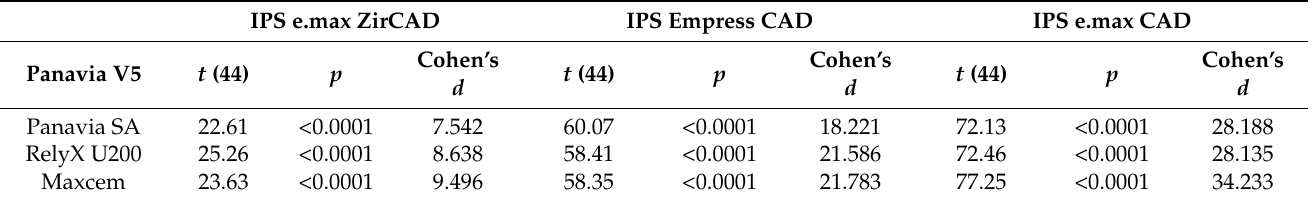
Table 1. Planned contrast analysis for differences in the shear bond strength between Panavia V5 and Panavia SA, RelyX U200, Maxcem respectively. The Cohen’s d for groups with equal size was calculated according to Lenhard, W. & Lenhard, A. [24].